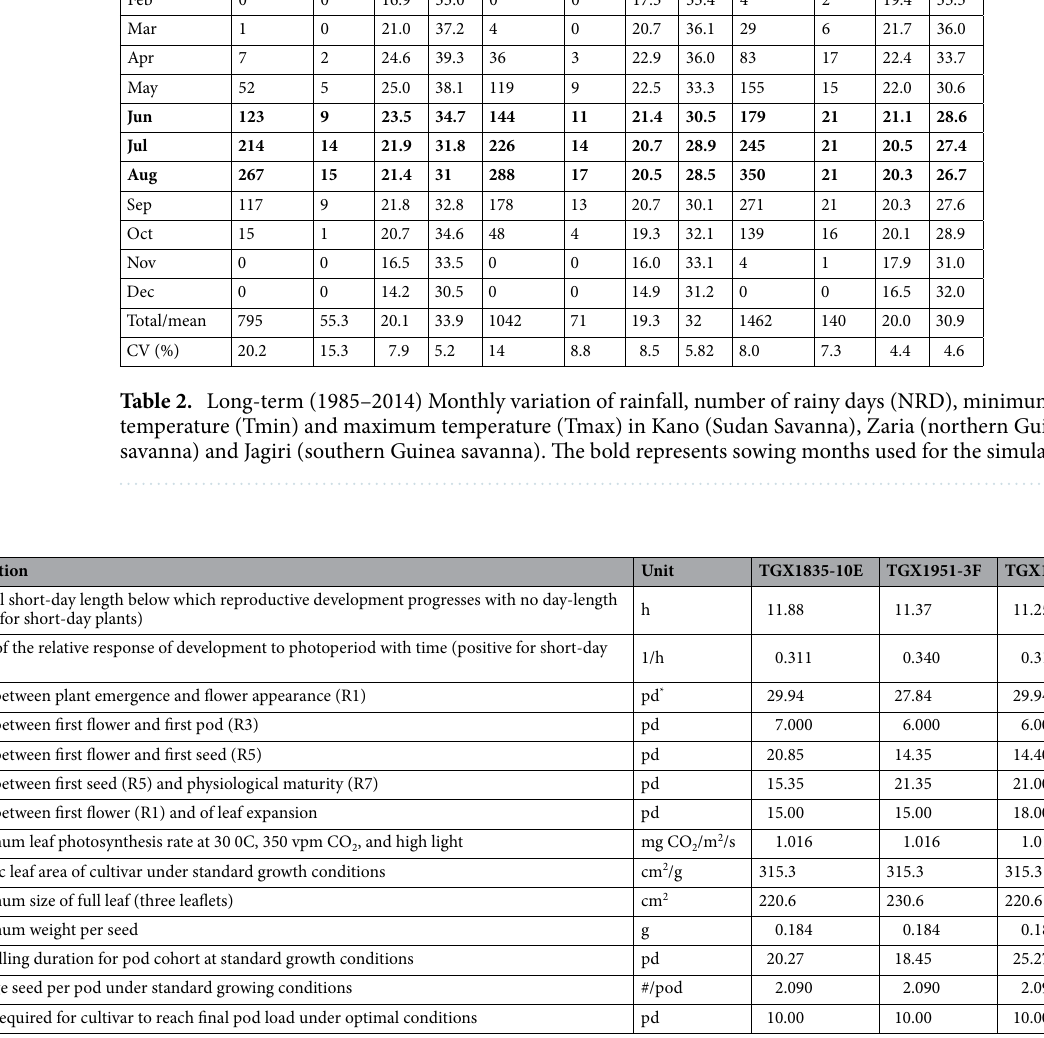
Table 3. Genetic coefficients of soybean cultivars used in the study. * pd photothermal